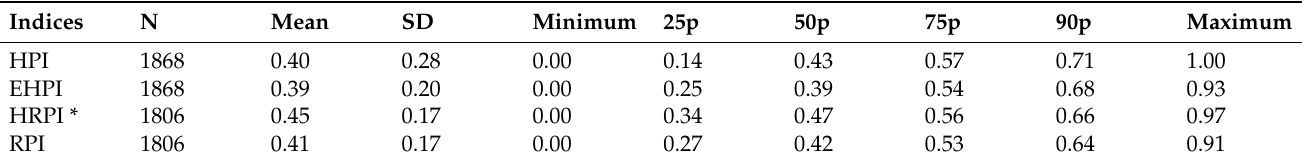
Table 3 (HPI 24 workers: mean = 0.28; SD = 0.20; EHPI 24 workers: mean = 0.32; SD = 0.12; HRPI 24 workers: mean = 0.31; SD = 0.16; RPI 24 workers: mean = 0.28; SD = 0.13), the 24 workers were excluded from the subsequent analyses to avoid selection bias. Table 3. Descriptive statistics of Hazard Perception Index, Exposure Hazard Perception Index, Health Risk Perception Index and Risk Perception Index.